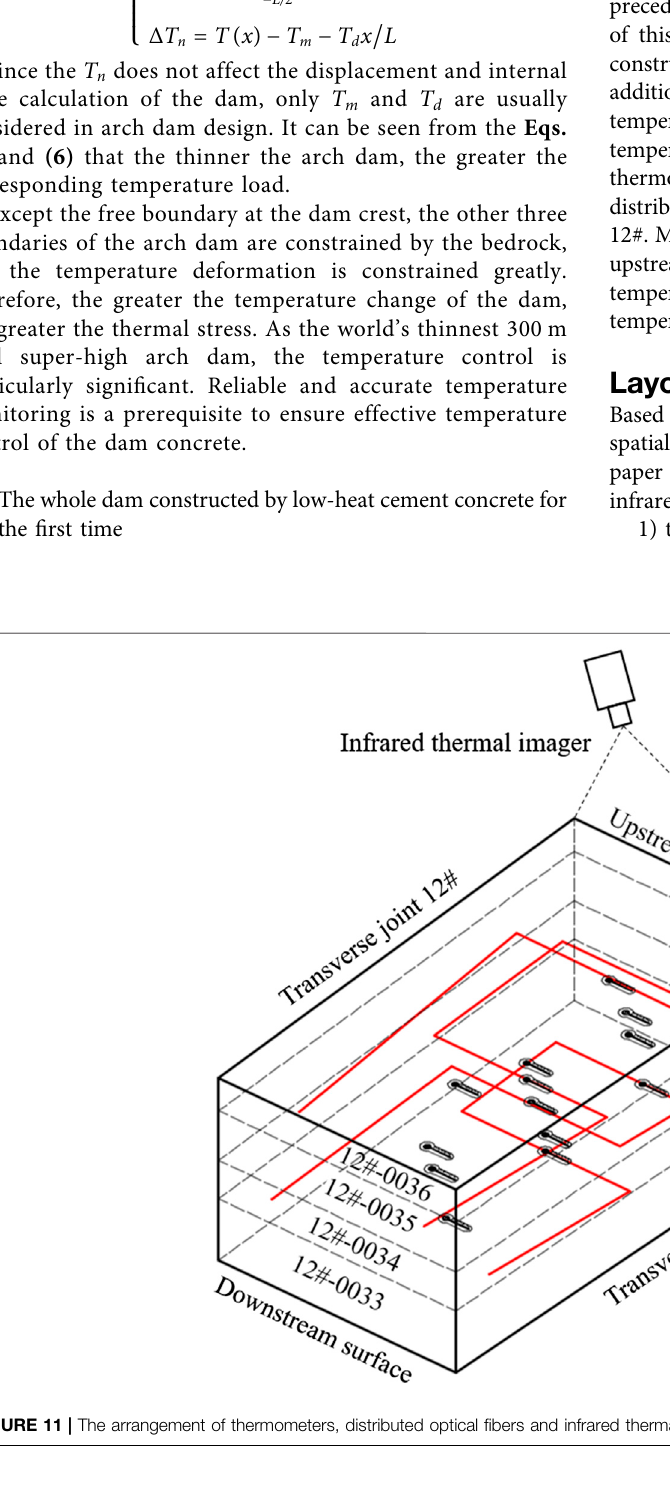
Frontiers in Materials |